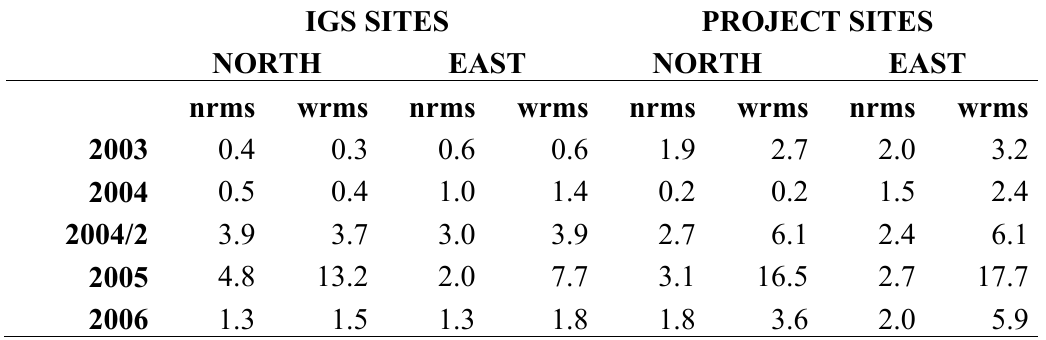
Table 3. Average nrms and wrms values with related periods in project sites and IGS